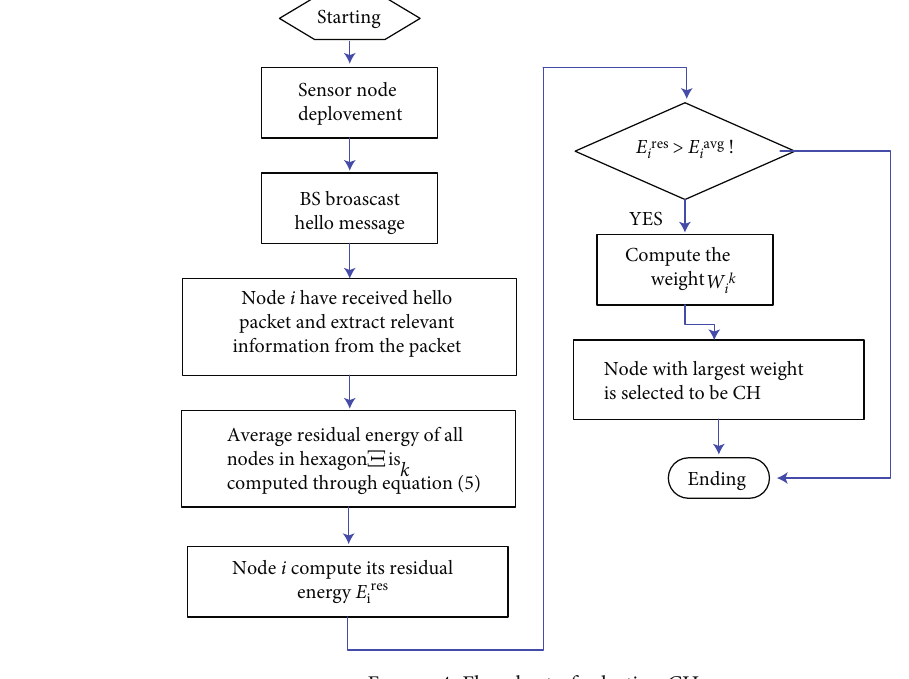
Figure 4: Flowchart of selecting CH.